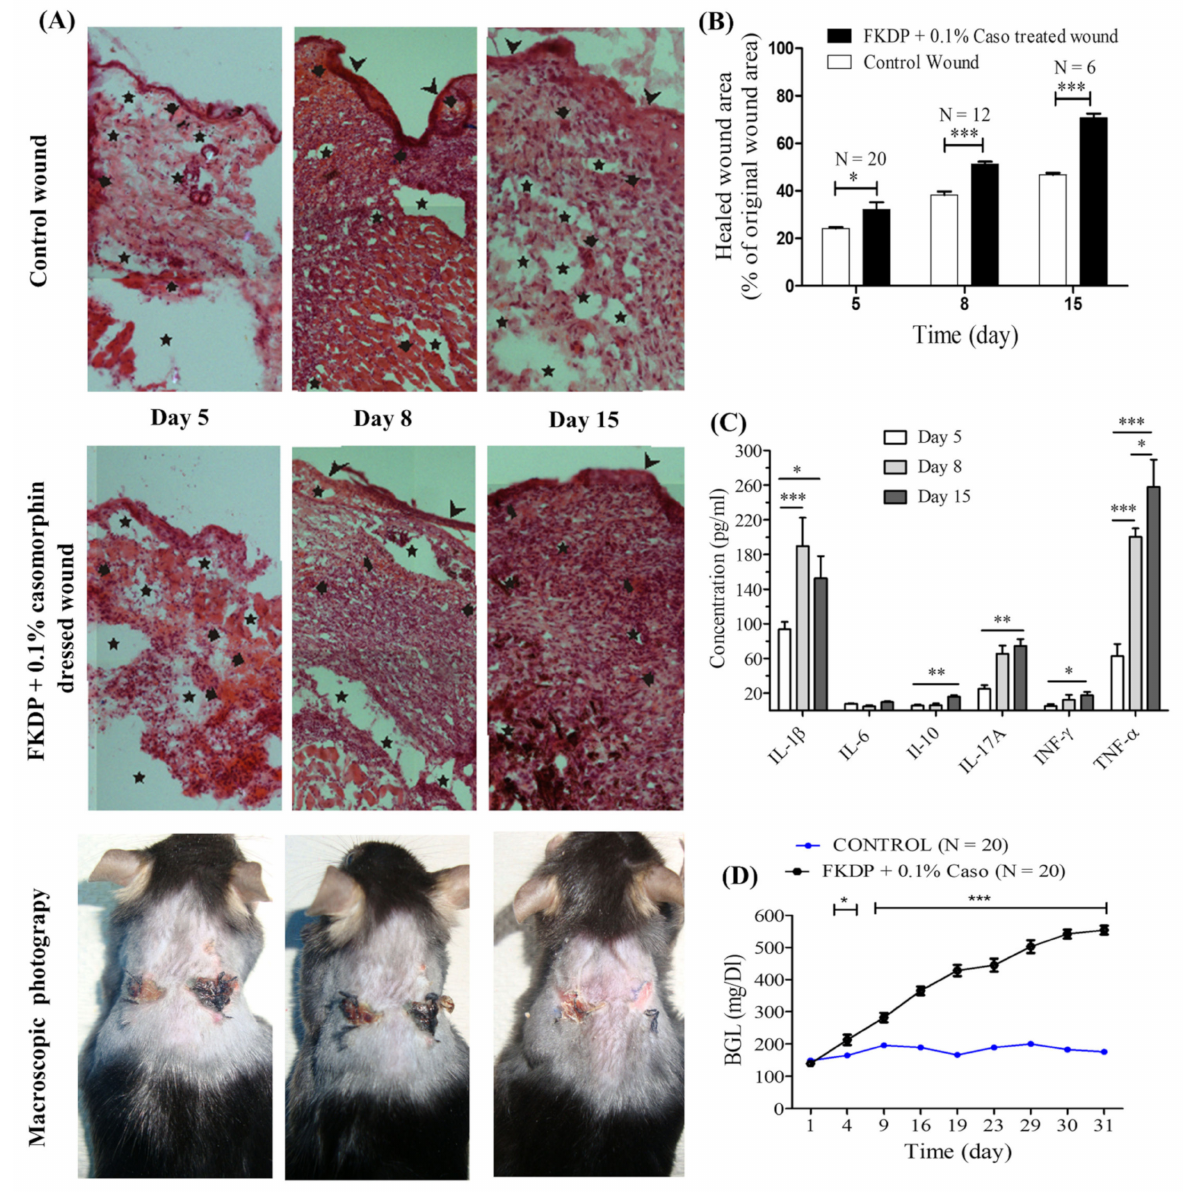
Figure 2. ( A ) Microscopic view of control and fur keratin-derived powder containing casomorphin (FKDP-0.1%Caso)- treated wounds during the course of healing; hematoxylin-eosin. Original magnification: 100 × . Legend: -epidermis; -hair follicle; -empty zones; -blood extravasation. ( B ) The effect of fur keratin-derived powder (FKDP) containing 0.1% casomorphin on skin wound healing. Because of the decreasing number of surviving mice, the data were only tested by the t-test for dependent samples (for each post-wounding day separately), with no prior two-way analysis of variance. Mice numbers at Day 5, N = 20; Day 8, N = 12; Day 15, N = 6. ( C ) Changes in cytokine level during wound healing in diabetic mice ( p -value < 0.05 was considered significant, were * p -value < 0.05, ** p -value < 0.01, *** p -value < 0.001). ( D ) Changes in blood glucose level (BGL) during diabetes induction. (The data were statistically significant if p < 0.05 two-way analysis of variance, followed by Bonferroni post hoc tests, mean ± standard error of the mean) (color online, black and white in